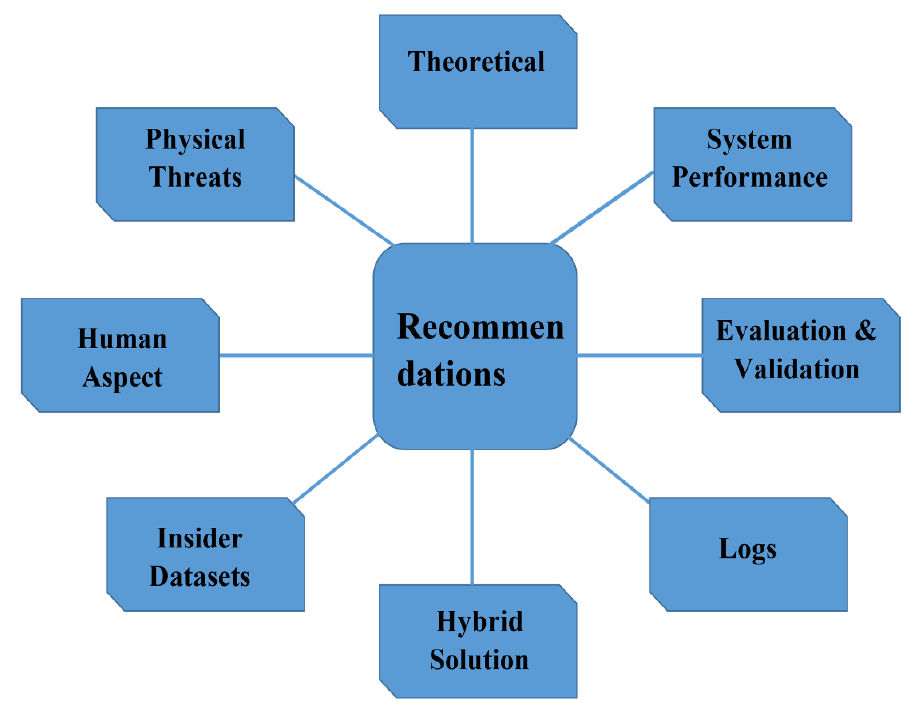
Figure 10. Figure 10. Recommendations.